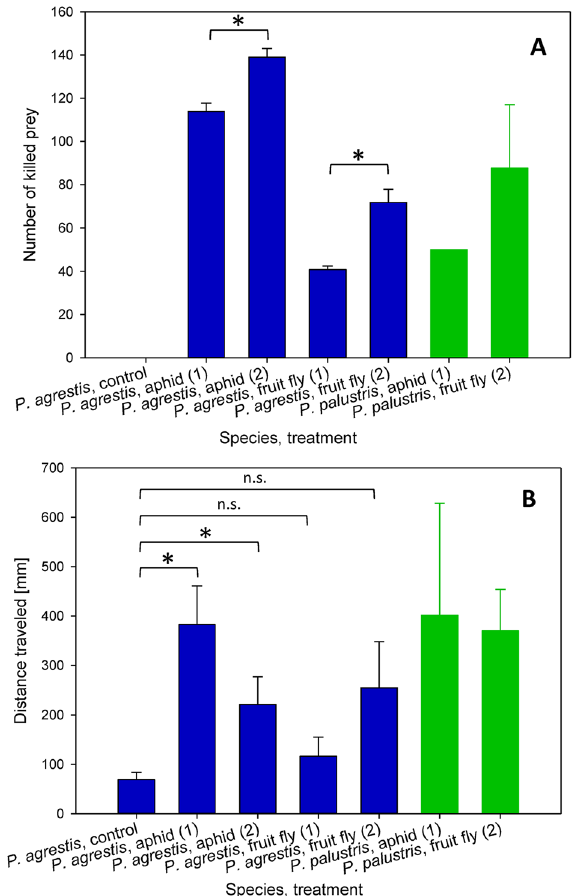
Figure 1. Number of killed prey ( A ) and traveled distance ( B ) in P. agrestis and P. palustris that were starved or fed at the indicated frequency with aphids or fruit flies. Asterisks indicate differences that were significant when tested using a one-sided t -test ( p < 0.05), and “n.s.” indicates comparisons that were not significant ( p ≥